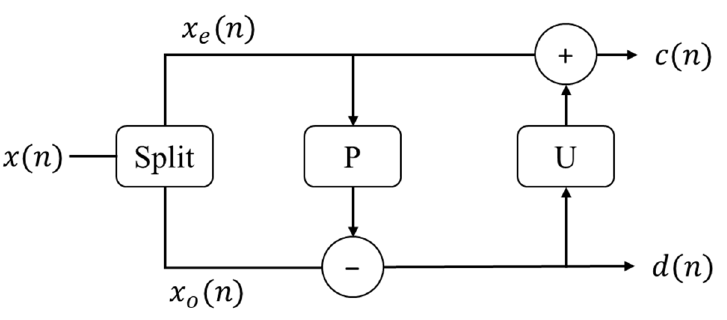
Figure 2. Lifting scheme.